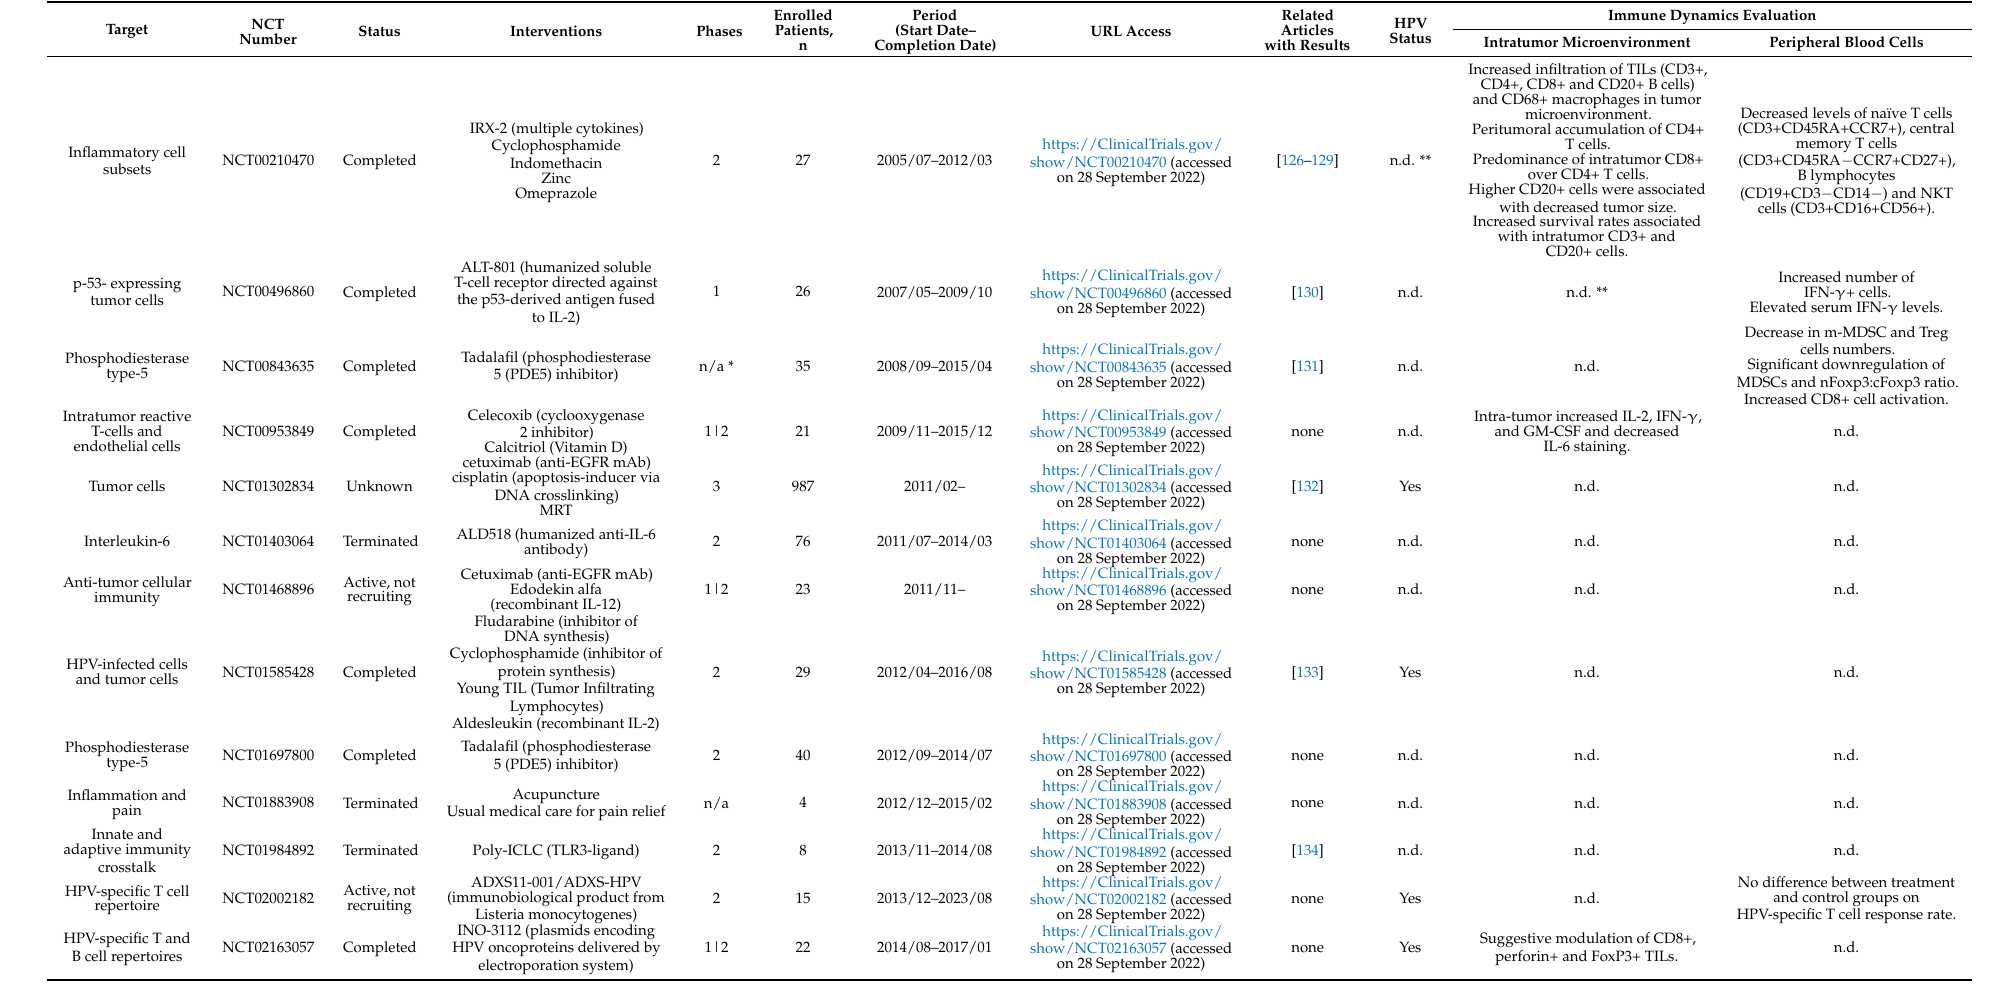
Table 1. Clinical trials for the treatment of HNSCC patients targeting the immune